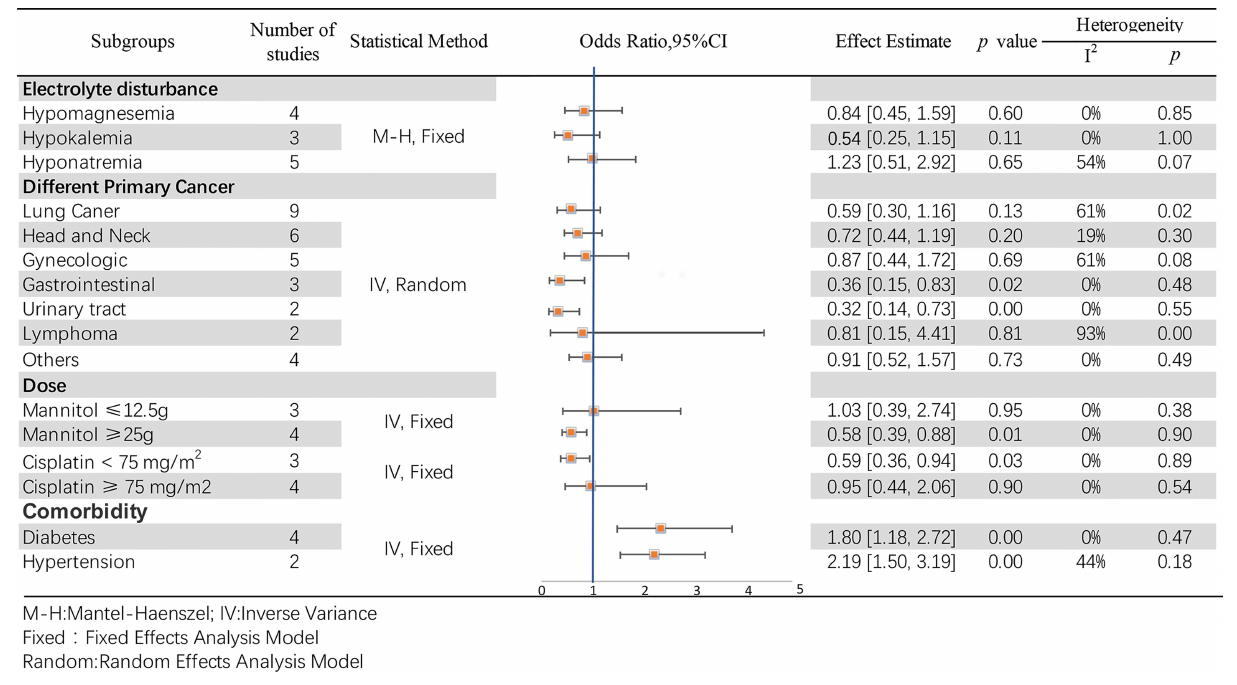
FIGURE 8 | Subgroup analyses of the association between mannitol and cisplatin-induced